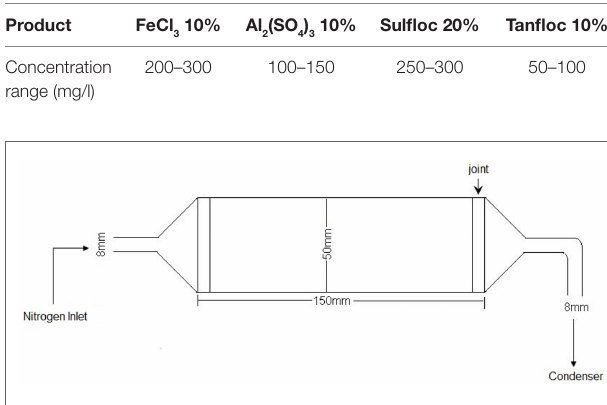
TaBle 2 | high-rate ponds performance.